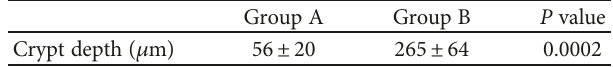
Table 3: Mean depth of crypts in groups A and